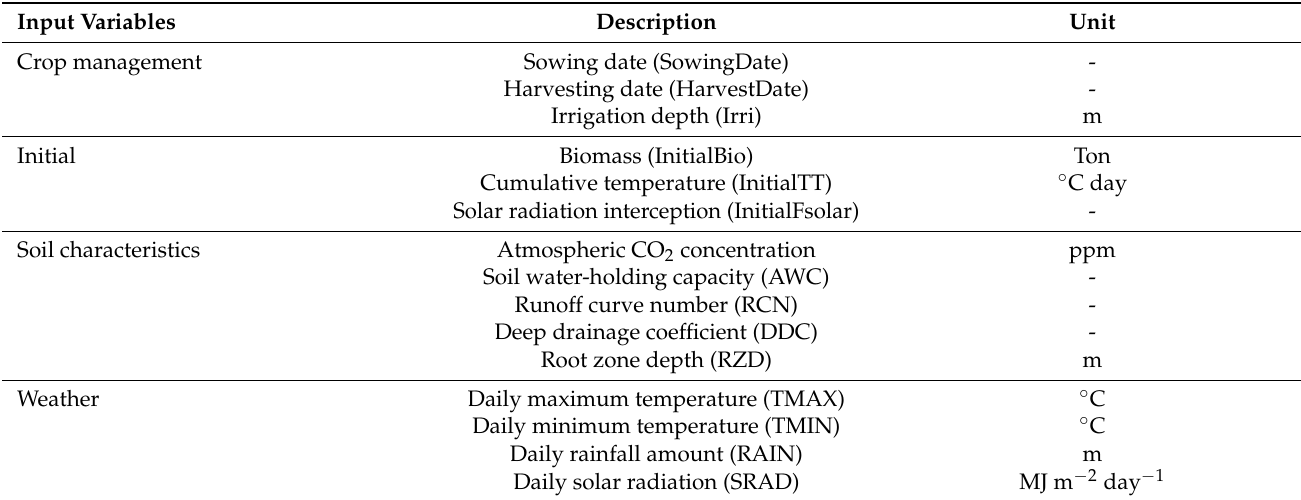
Table 4. Input variables of SIMPLE model adapted from Zhao et al.